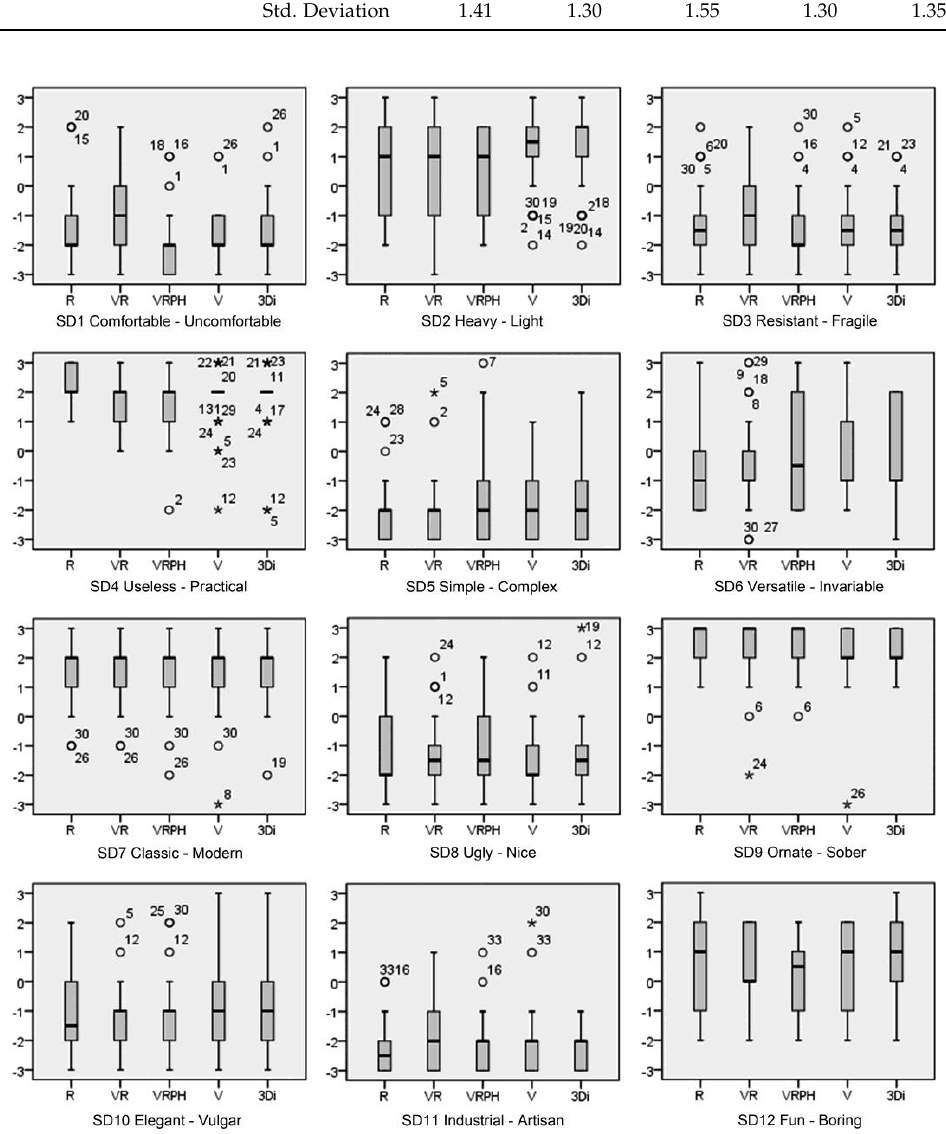
Figure 5. Box plots for the semantic scales. Outliers outside 1.5 times the interquartile range above the upper quartile and below the lower quartile are represented by an open circle. Extreme outliers are marked with an asterisk.